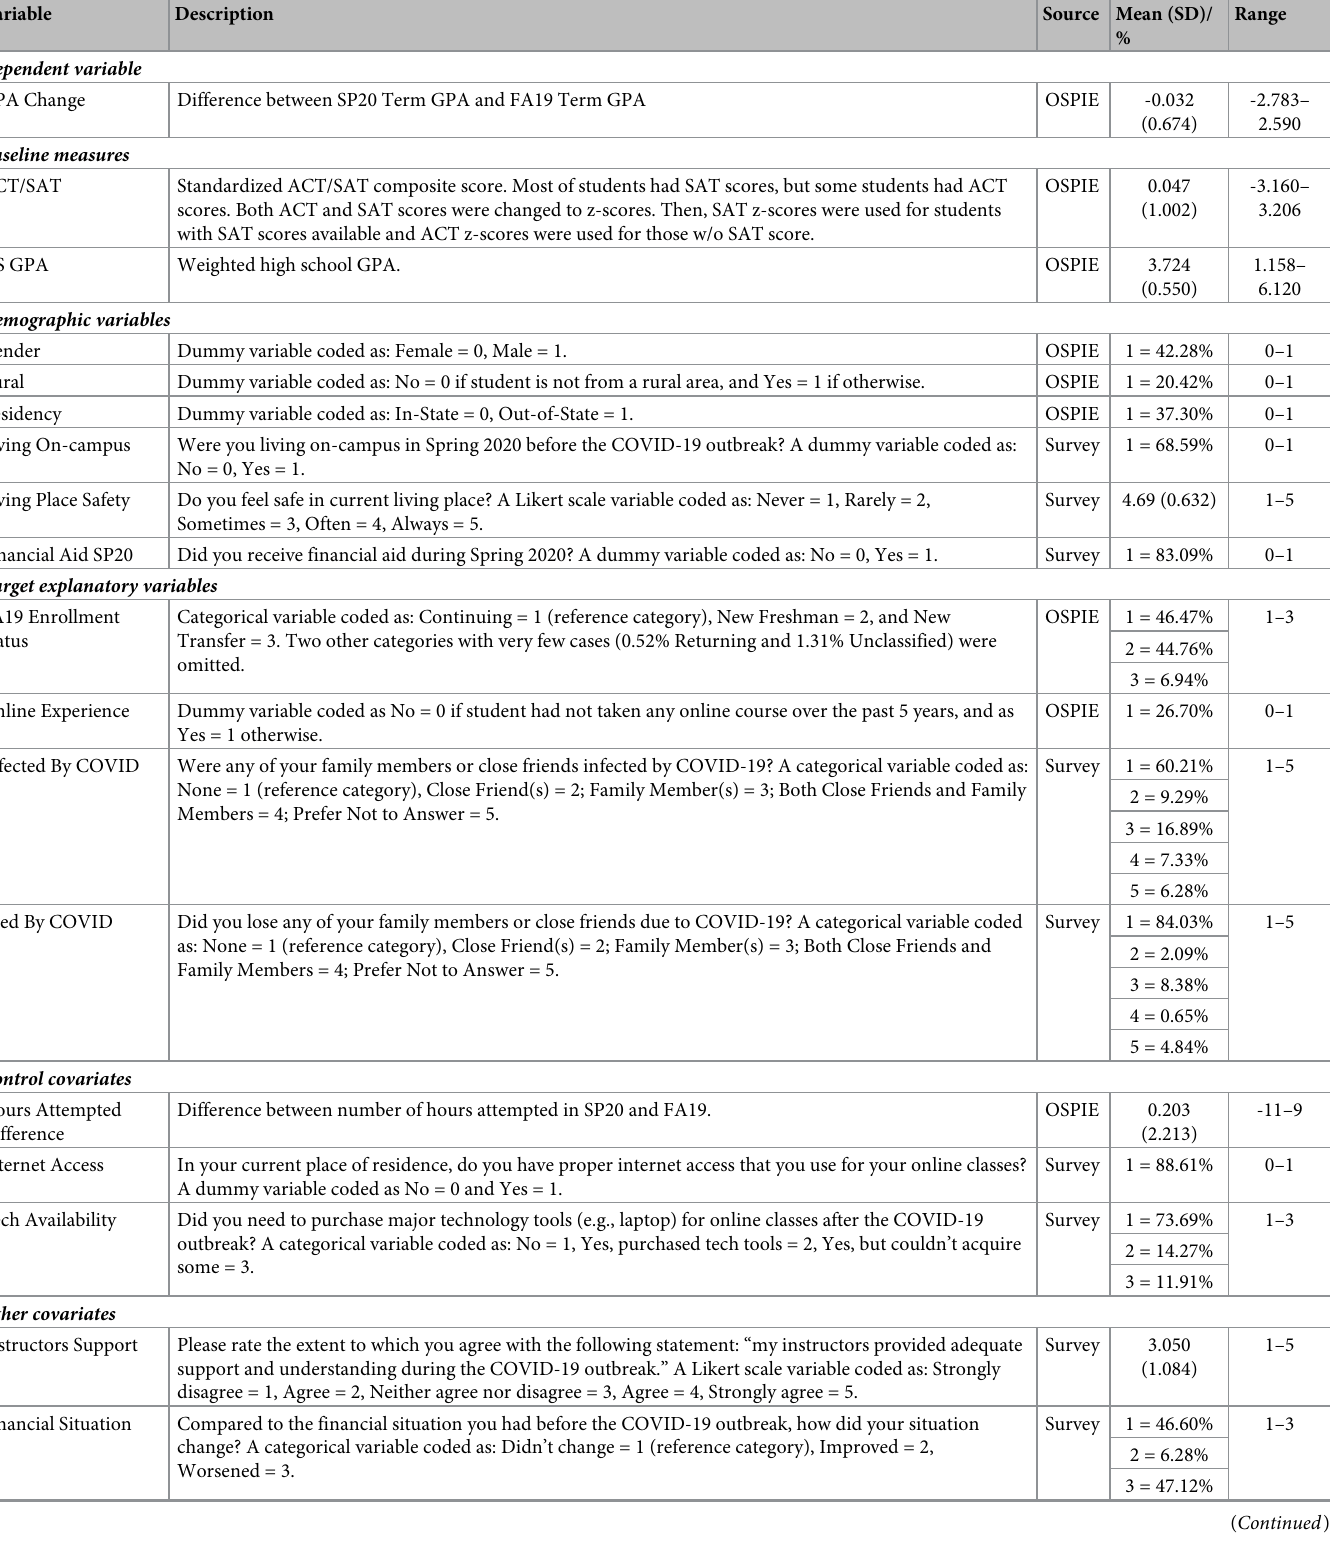
Table 1. Descriptions and summary statistics for the variables used in the